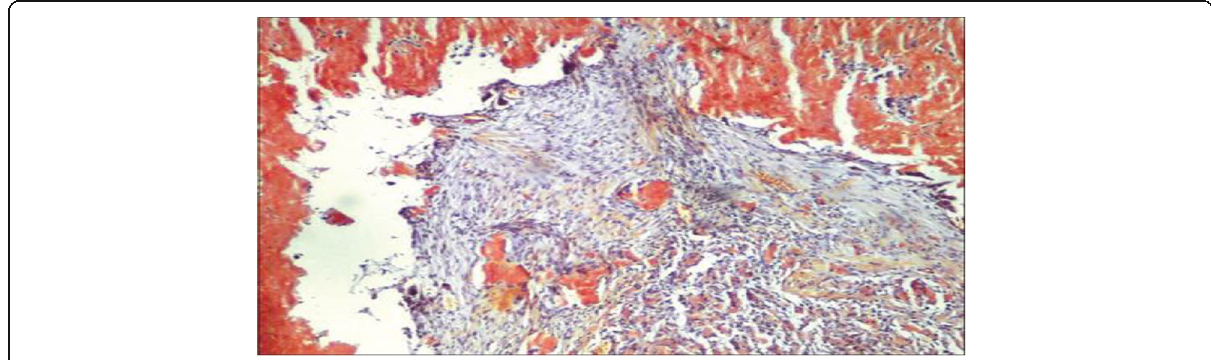
Fig. 2 Histopathology of lung biopsy. Congo red staining showed marked thickening of the alveolar wall and deposition of amorphous eosinophilic amyloid at the bronchial mucosa, pulmonary vessel wall, and